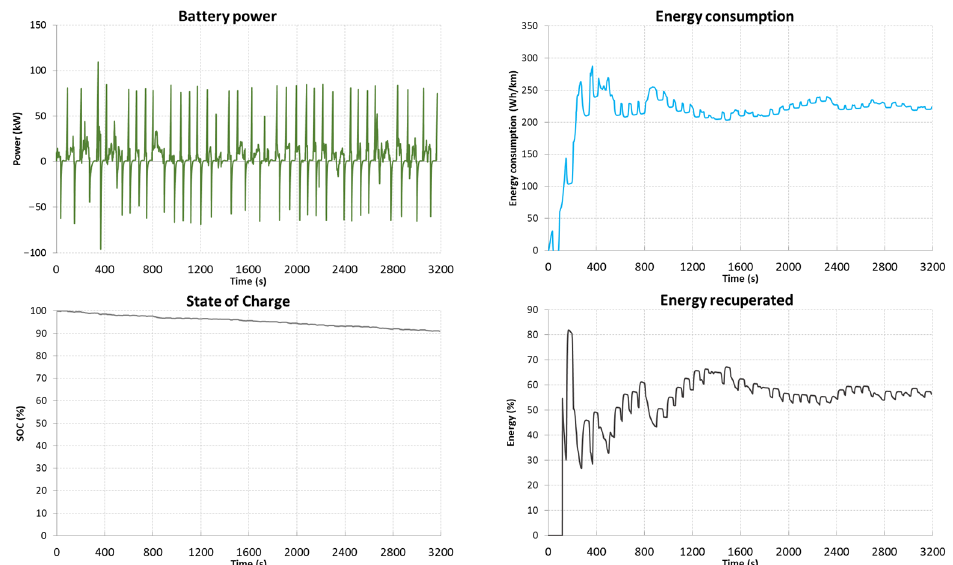
Figure 13. City Flat Road results of simulation tests for the 4 × 4 drive system with Type 1 energy storage.